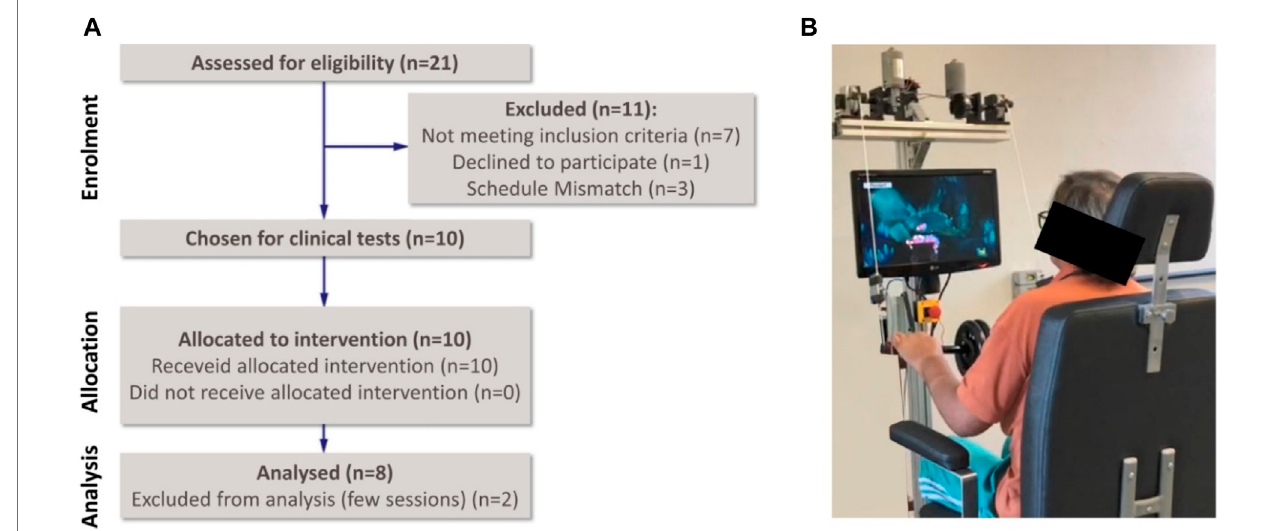
FIGURE 11 | Clinical tests with post-stroke patients: (A) Consolidated Standards of Reporting Trials fl ow diagram, (B) system interfaced with a subject.